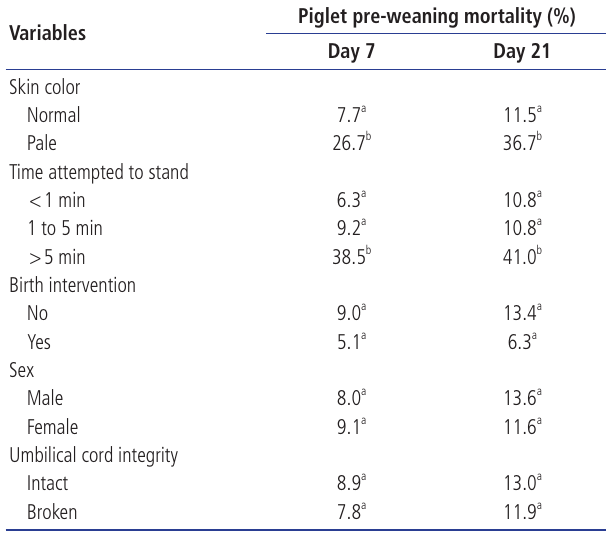
Table 3. Categorical variables influencing piglet pre-weaning mortality at day 7 and 21 after birth